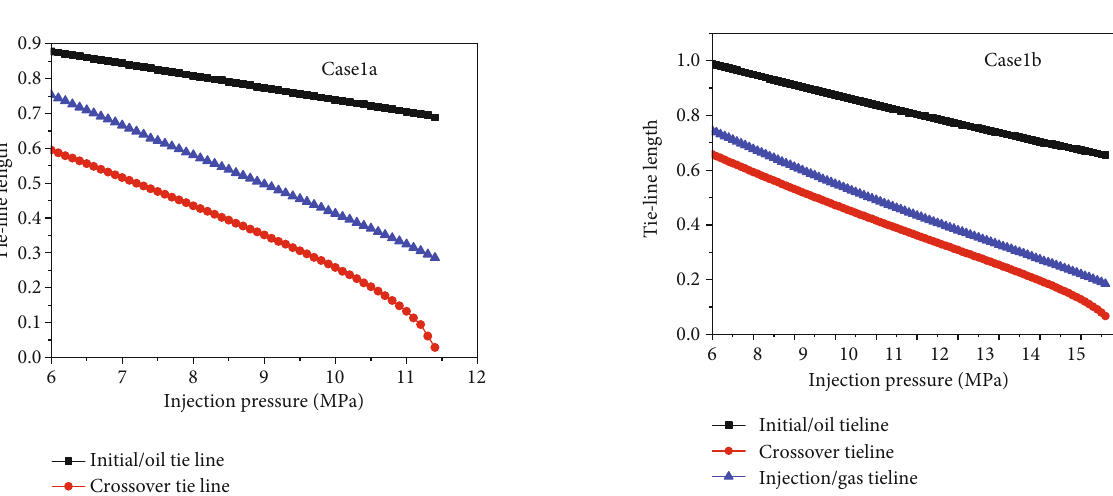
Figure 5: Variation of key tie-line lengths vs. pressure for Case 1b. The MMP was estimated to 15.96 MPa (2314psia).